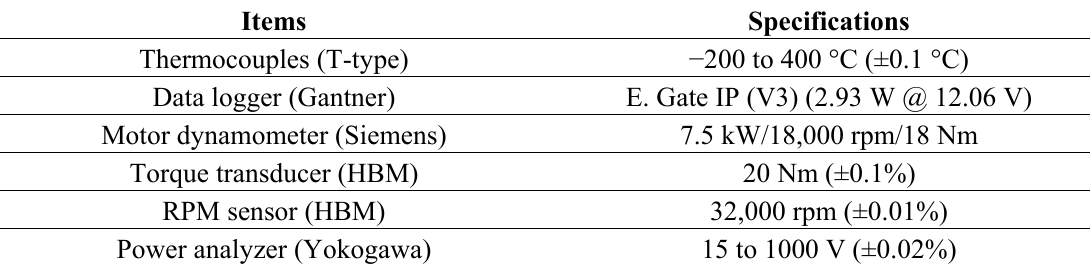
Table 5. Specifications of test equipment.